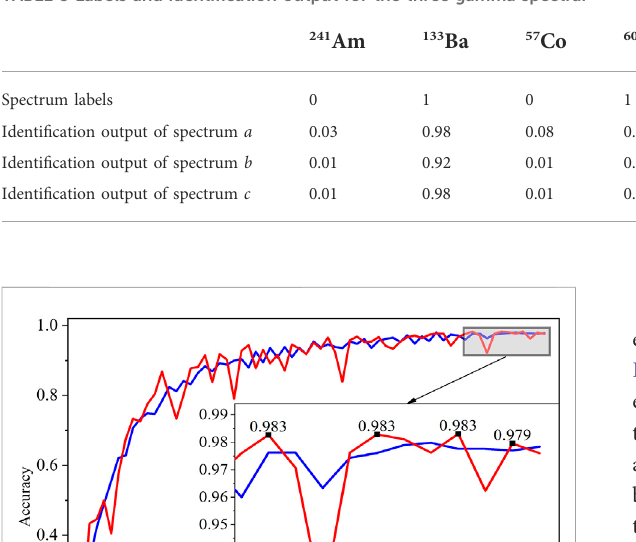
TABLE 3 Labels and identi fi cation output for the three gamma spectra.